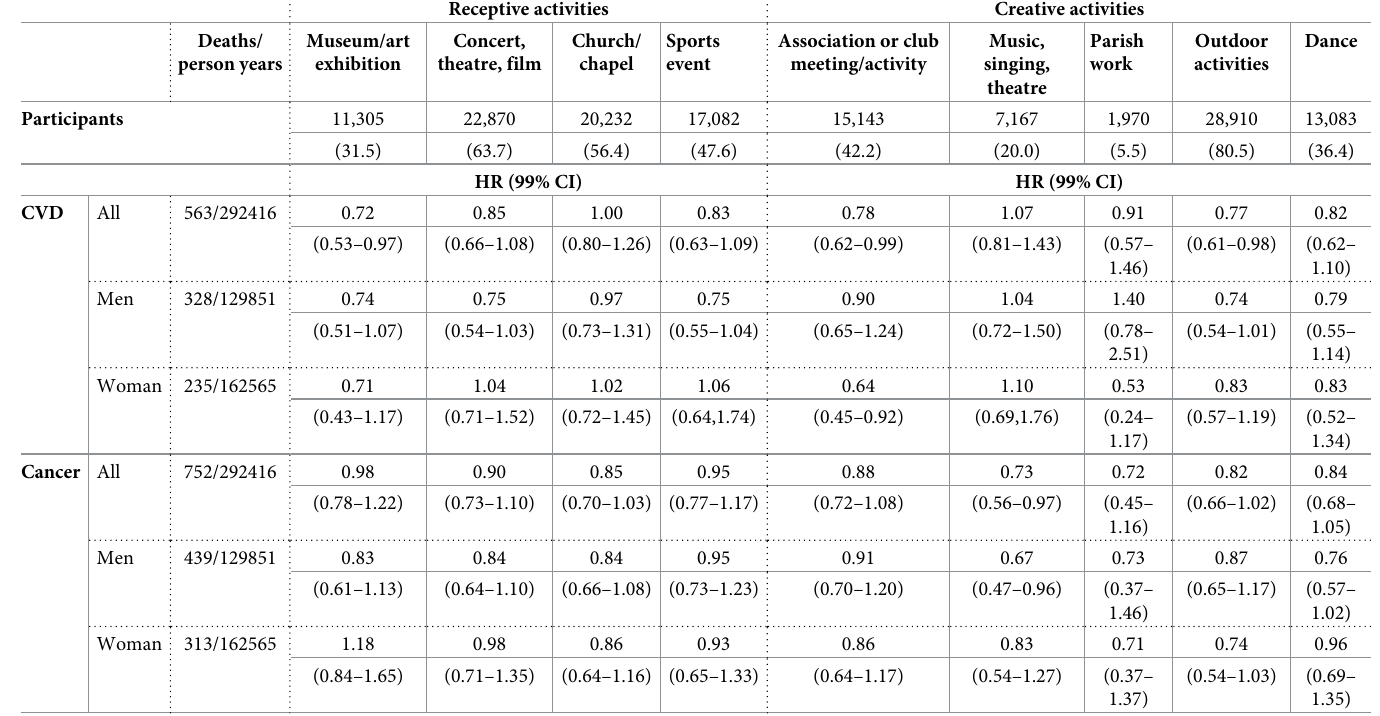
Table 3. Total and gender-specific associations (based on adjusted † hazard ratios and 99% confidence intervals) between participation in one or more receptive/cre- ative cultural activities and cardiovascular-disease- and cancer-related mortality (n = 35,902). The HUNT Study